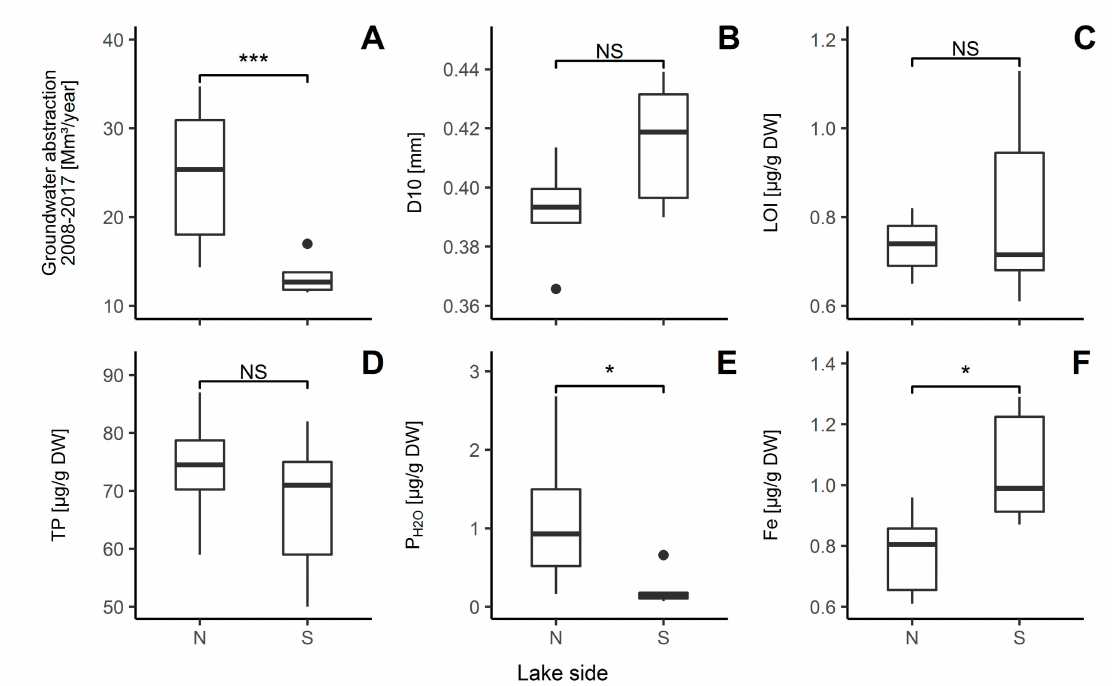
Figure 2. Groundwater abstraction rates of wells at Lake Müggelsee (( A ), yearly average from 2008–2017, North-eastern (N) shore: Galleries C–D, South-western (S) shore: Galleries E–F; data from Berlin senate) and parameters of littoral sediment taken from the N and S shores (see Figure 1): Particle diameter at 10% of the cumulative weight (( B ), D10), loss on ignition at 450 ◦ C (( C ), LOI) and content of total phosphorus (( D ), TP), aerobic soluble phosphorus (( E ), P H2O ) and iron (( F ), Fe). * Indicates a p-value < 0.05, *** a p-value < 0.001 and NS a p-value >